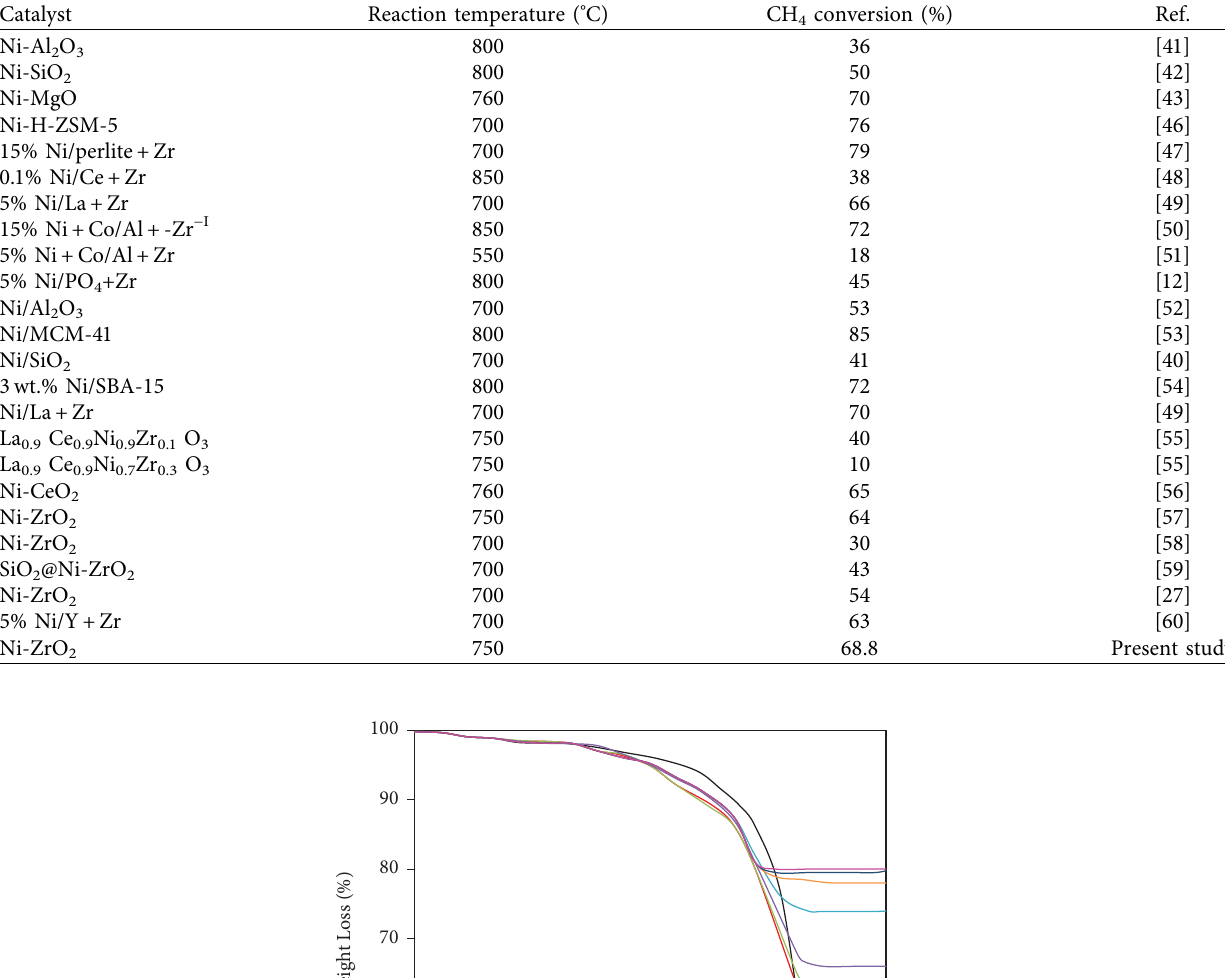
Table 3: Performance comparison with that of other